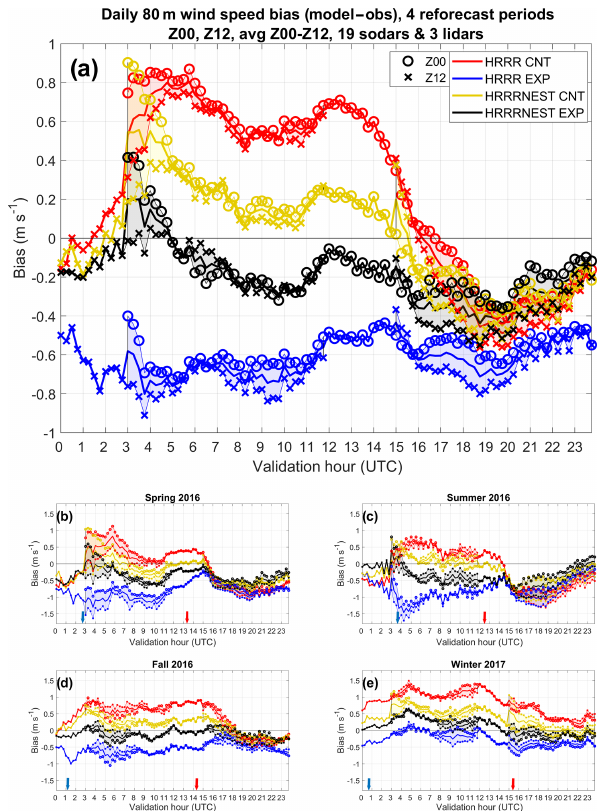
Figure 2. As in Fig. 1 but for the 80m wind speed biases.